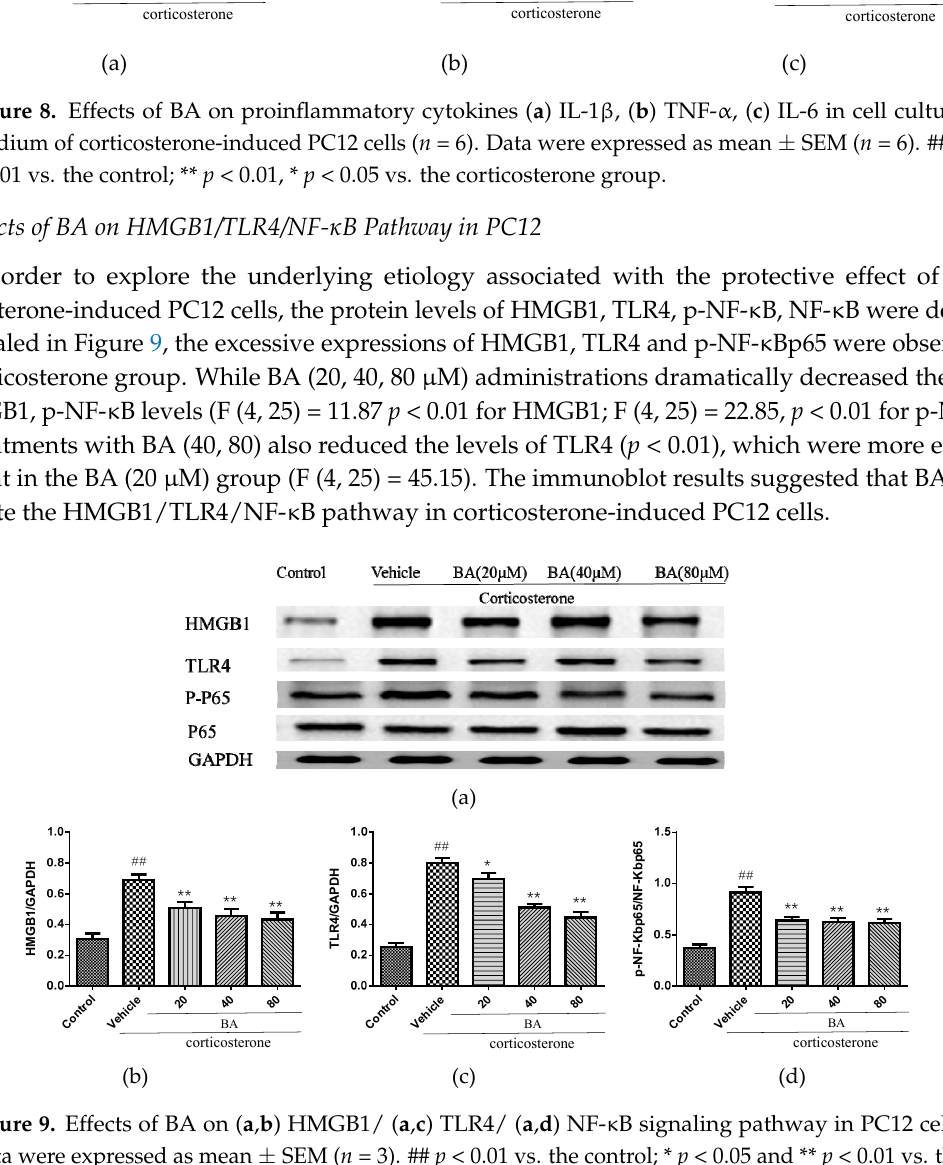
Figure 8. Effects of BA on proinflammatory cytokines ( a ) IL-1 β , ( b ) TNF- α , ( c ) IL-6 in cell culture medium of corticosterone-induced PC12 cells ( n = 6). Data were expressed as mean ± SEM ( n = 6). ## p < 0.01 vs. the control; ** p < 0.01, * p < 0.05 vs. the corticosterone group.